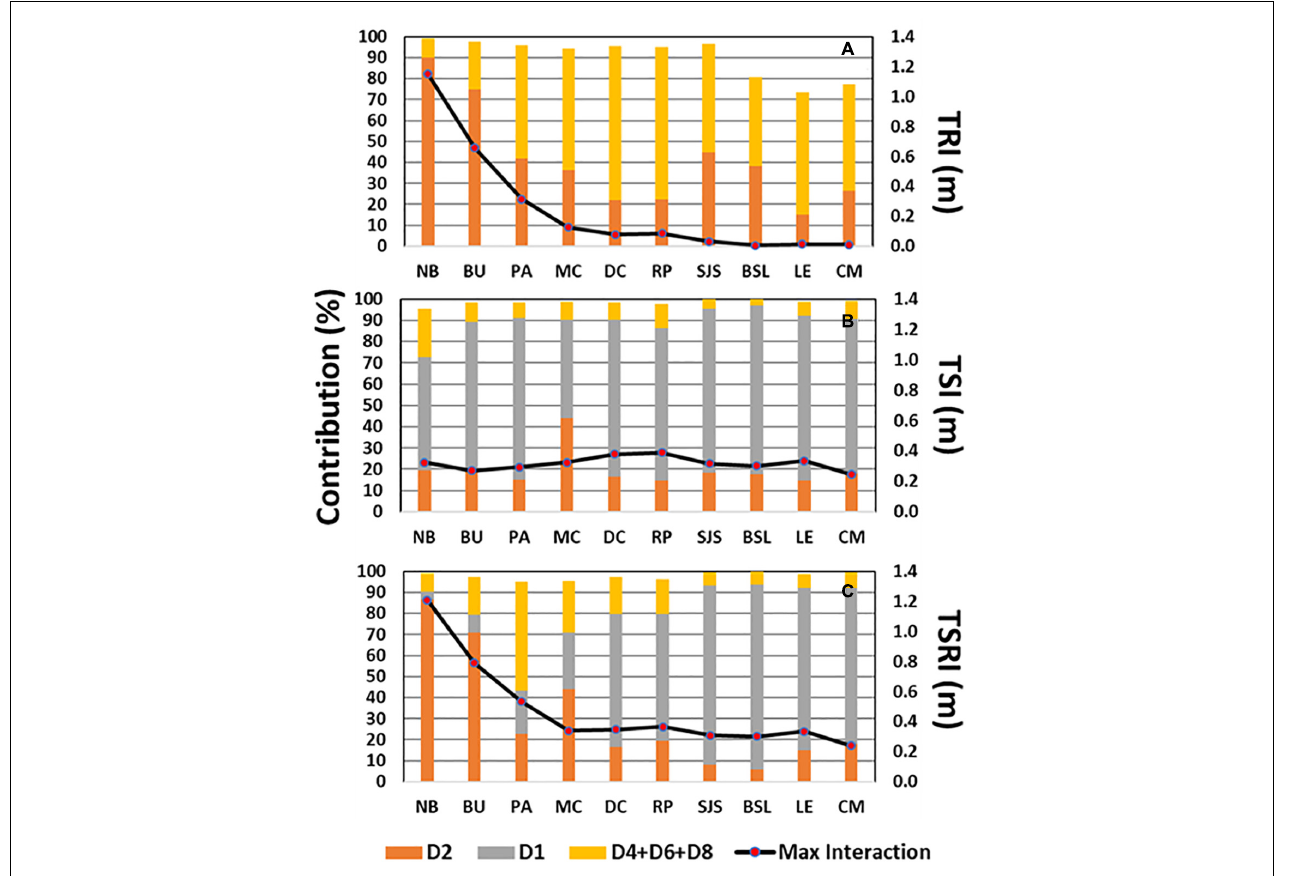
FIGURE 13 | Peak values of (A) TRI, (B) TSI, (C) TSRI (black lines), and the percentage of relative contributions from different tidal bands [D2 – semi-diurnal band (red); D1 – diurnal band (gray); D4+D6+D8 – high-frequency (orange)] to the total variance of corresponding non-linear interactions at 10 tidal gauges.